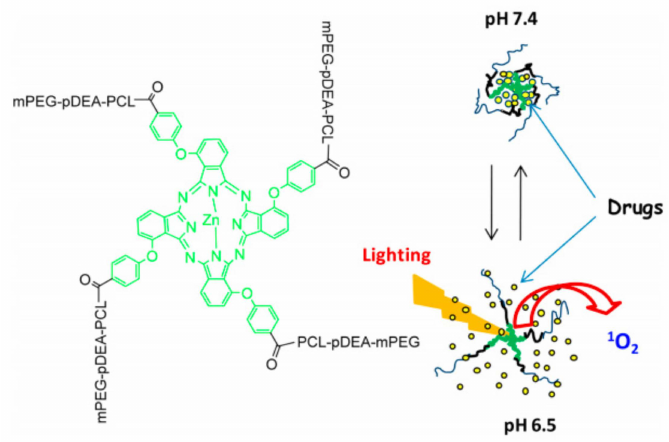
Scheme 12. Schematic illustration of PDCZP and action of its pH-dependent drug release and combined therapy of chemotherapy and PDT. Reprinted with permission from ref [78]. Copyright 2017 American Chemical